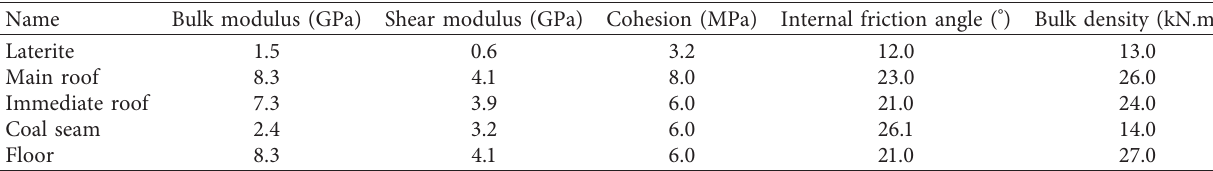
Figure 6: Model Table 3: Parameters of roof, floor, and coal.